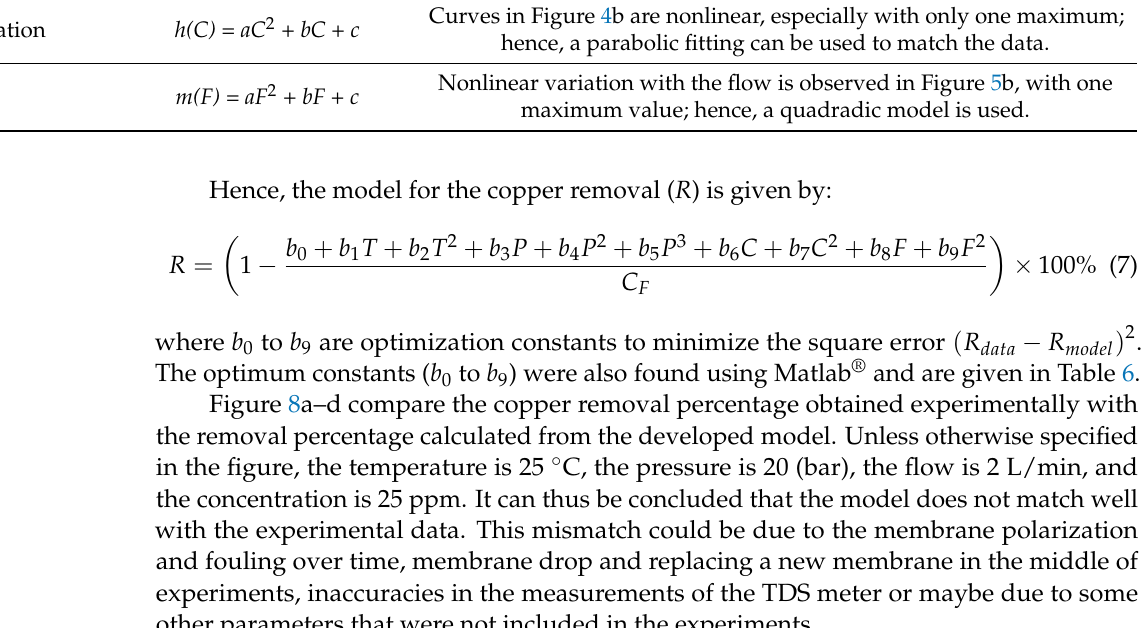
Table 5. Relationship function between concentration in permeate ( C p ) and the parameters. Permeate Flux vs. Nonlinear curves observed in Figure 3b are similar to parabolic curves. Curves in Figure 2b have maxima and minima. A quadratic equation will be insufficient to model this curve because it has only one minima/ maxima; hence, a higher-order (cubic) function is required. Curves in Figure 4b are nonlinear, especially with only one maximum; hence, a parabolic fitting can be used to match the data. Nonlinear variation with the flow is observed in Figure 5b, with one maximum value; hence, a quadradic model is